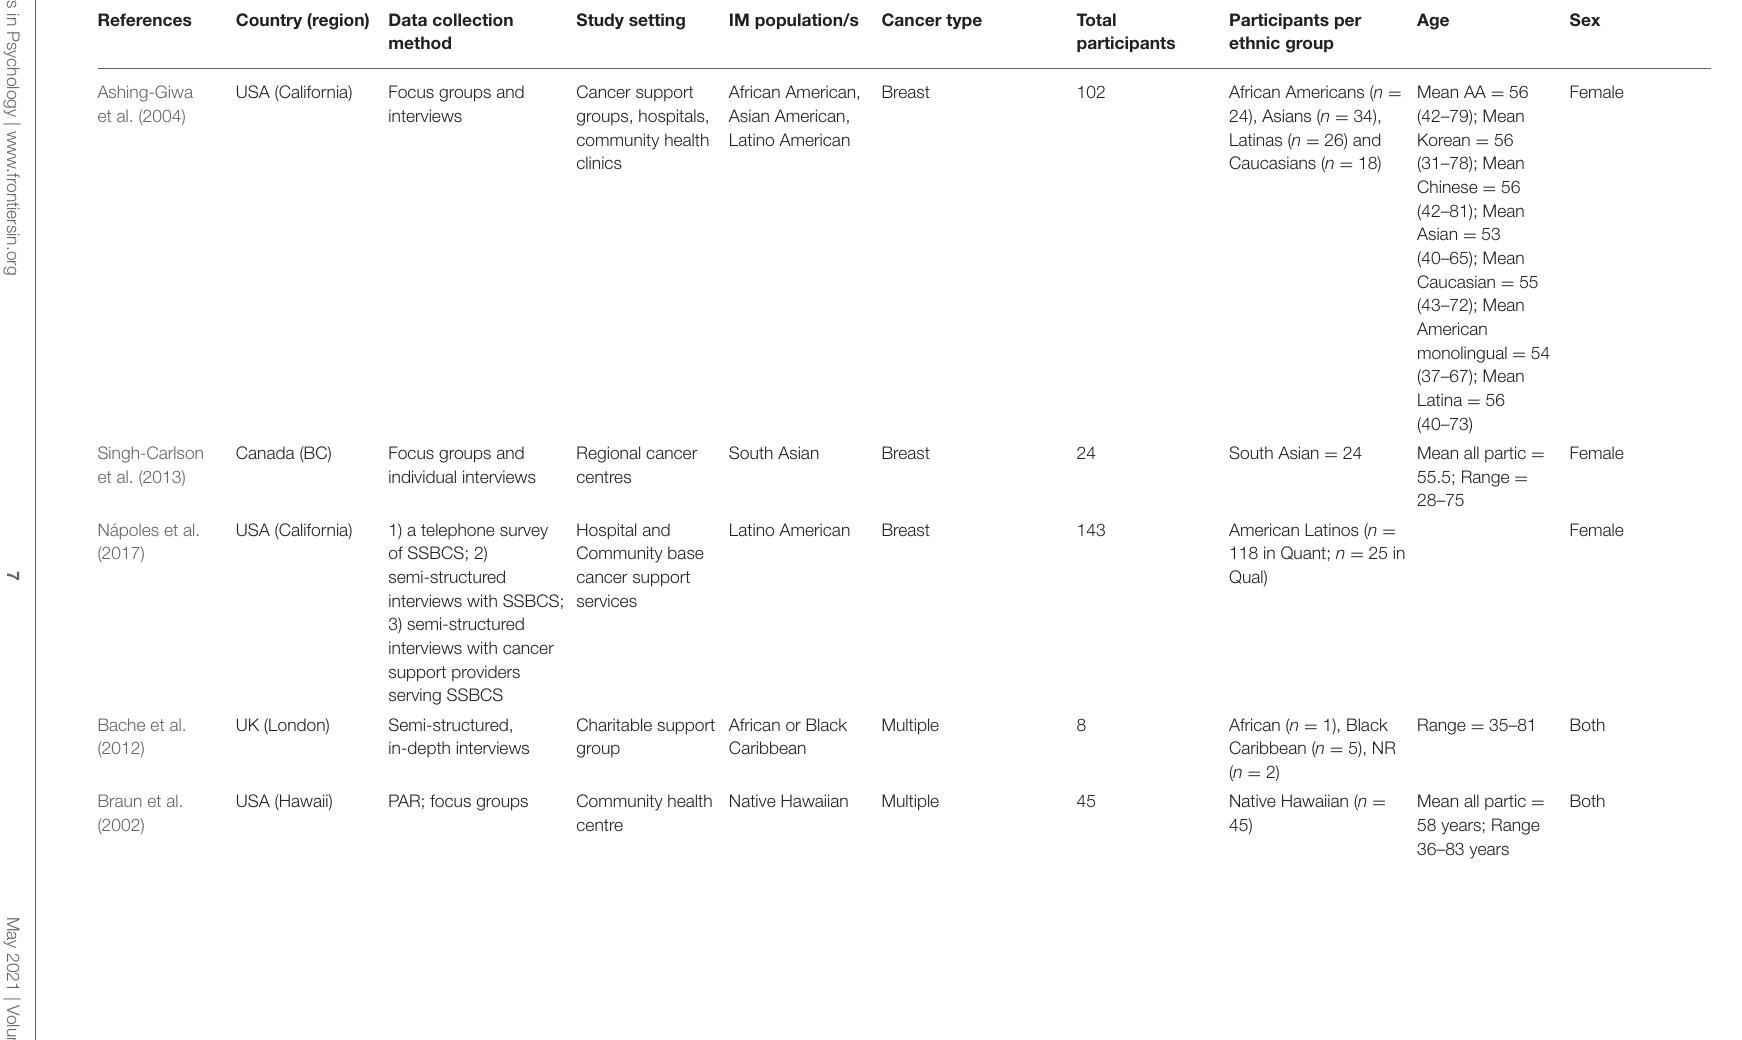
TABLE 2 | Characteristics of included qualitative